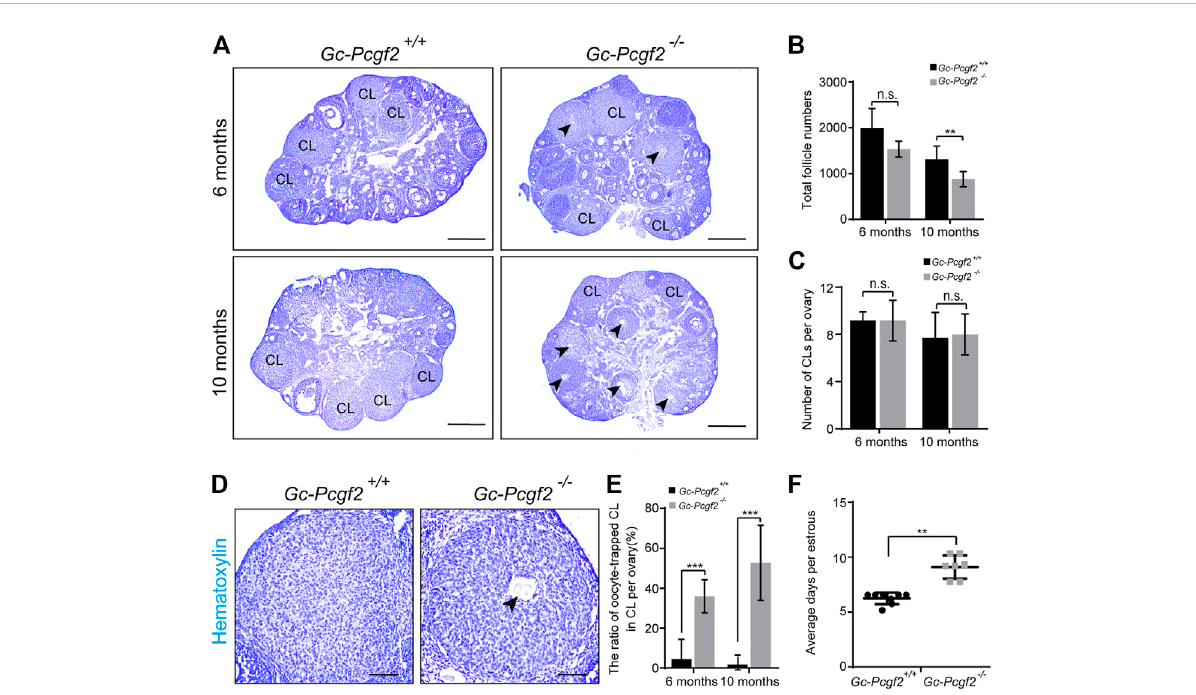
FIGURE 2 Deleting Pcgf2 from ovarian follicle granulosa cells accelerates follicle loss and disrupts the estrus cycle. (A) Histological analysis showing the corpus luteum contained entrapped oocytes (arrowheads) were found in GC-Pcgf2 − / − ovaries at 6 months and 10 months. CL, corpus luteum. Arrowheads, oocytes entrapped inCLs. Scale bars: 500 µm. (B) Follicle counting result showing identical numbers of thetotal follicle infemale mice at 6 months (1585 ± 182 in GC-Pcgf2 − / − vs. 1994 ± 379 in GC-Pcgf2 +/+ ; n = 5 per group) and a signi fi cantly decreased total follicle number in GC-Pcgf2 − / − mice at 10 months (878 ± 156 in GC-Pcgf2 − / − vs. 1310 ± 270 in GC-Pcgf2 +/+ ; n = 8 per group). (C – E) Histological analysis of corpus luteum showing signi fi cantly higher ratio of oocytes entrapped in CLs of GC-Pcgf2 − / − ovaries, compared with those in the controls at 6 months and 10 months. (C) CLcountingresultsshowinganidenticalnumberofCLsinovariesat6 months(9±2in GC-Pcgf2 − / − vs.9±1in GC-Pcgf2 +/+ ; n =6per group)and10 months(9±2in GC-Pcgf2 − / − vs.7±2in GC-Pcgf2 +/+ ; n =8pergroup). (D) DetailedhistologicalanalysisofCLsshowingthestructures of CL entrapped with oocyte (arrowheads) of GC-Pcgf2 − / − ovaries at 6 months. Scale bars: 100 µm. (E) Quantitative result showing signi fi cantly higher ratio ofoocyte-trapped-CL in GC-Pcgf2 − / − (6 months: 36% ± 7%; 10 months: 53% ± 17%) compared with inthe controls (6 months: 4%± 9%; 10 months: 2% ± 4%; 6 months: n = 6 per group, 10 months: n = 8 per group). (F) Quantitative result showing a longer estrus cycle in GC-Pcgf2 − / − (9±1 day; n =7)comparedwithinthecontrols(6±0 days; n =8).Theexperimentswererepeatedatleastthreetimes.Thedatain (B,C,E,F) represent the results (mean ± SD) of the biological triplicate experiments. n.s. p > 0.05, ** p < 0.01, and *** p < 0.001 by two-tailed unpaired Student ’ s t